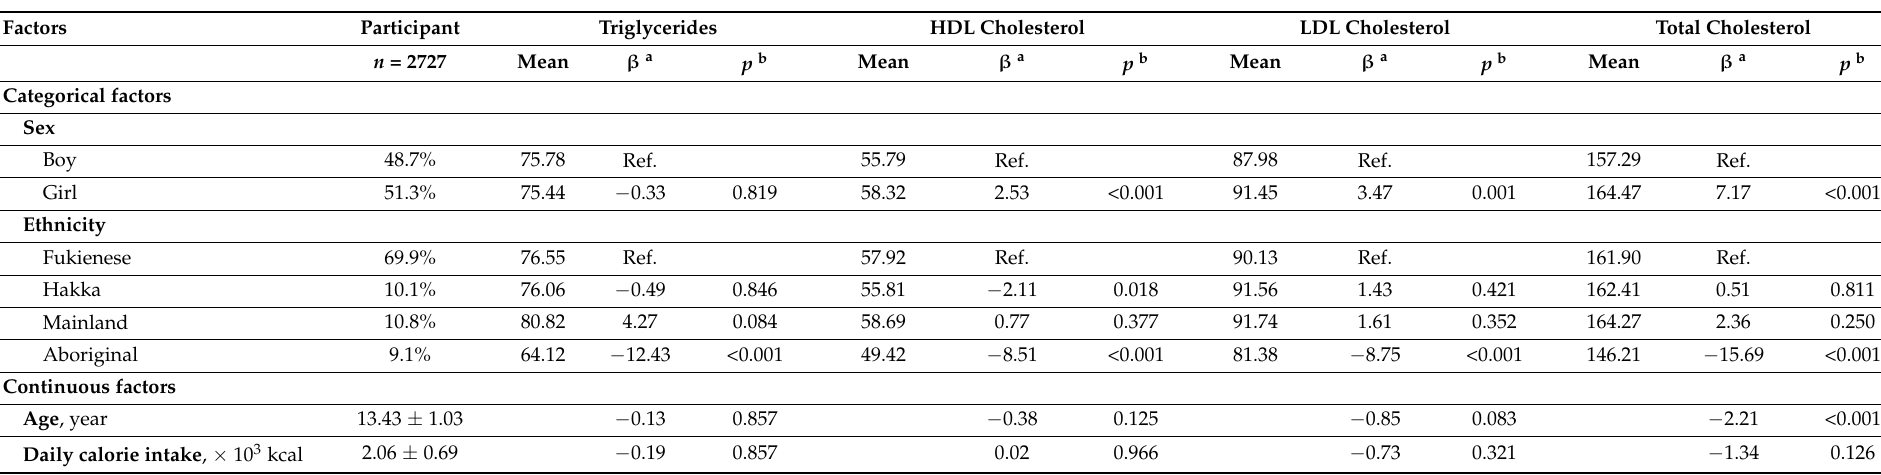
Table 1. The distributions of lipid profiles (mg/dL) associated with demographic factors and daily calorie intake in